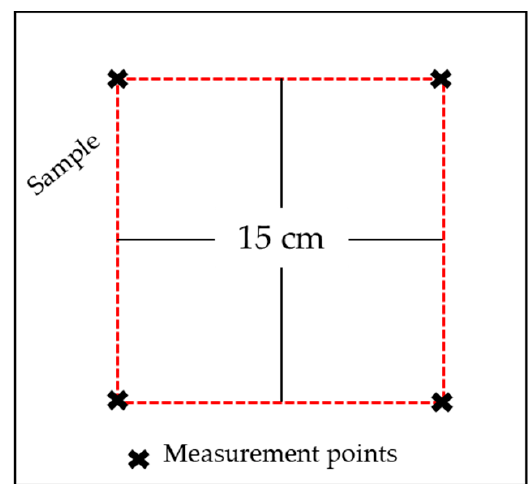
Figure 8. Sample labelling. Figure 8. Sample Table 4. Results of dimensional changes.